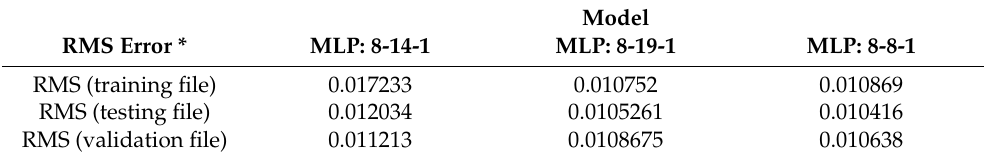
Table 5. RMS error for generated MLP: 8-14-1, MLP: 8-19-1 and MLP: 8-8-1 neural topologies.